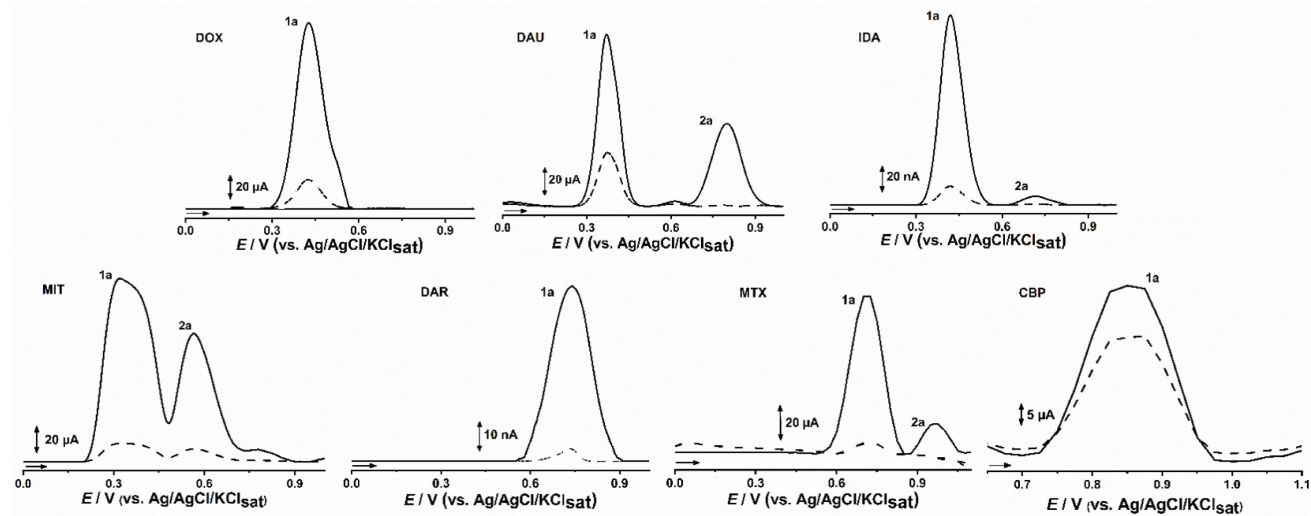
Figure 2. DP voltammograms obtained for CPE (– – –) CPDE (—) in pH 7.0 0.1 M PBS after 60 s immersion in 1 mM solutions of DOX, DAU, IDA, MIT, DAR, MTX, and